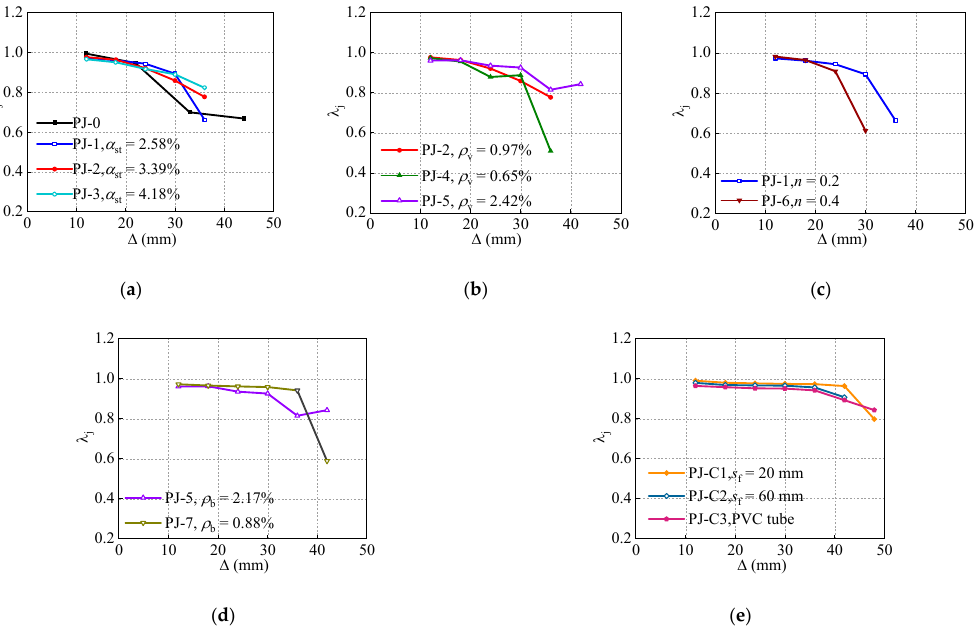
Figure 10. Effects of design parameters on the strength degradation coefficient. ( a ) Steel ratio of STC. ( b ) Stirrup ratio of the joint. ( c ) Axial compression ratio. ( d ) Reinforcement ratio of the frame beam. ( e ) CFRP strips spacing.